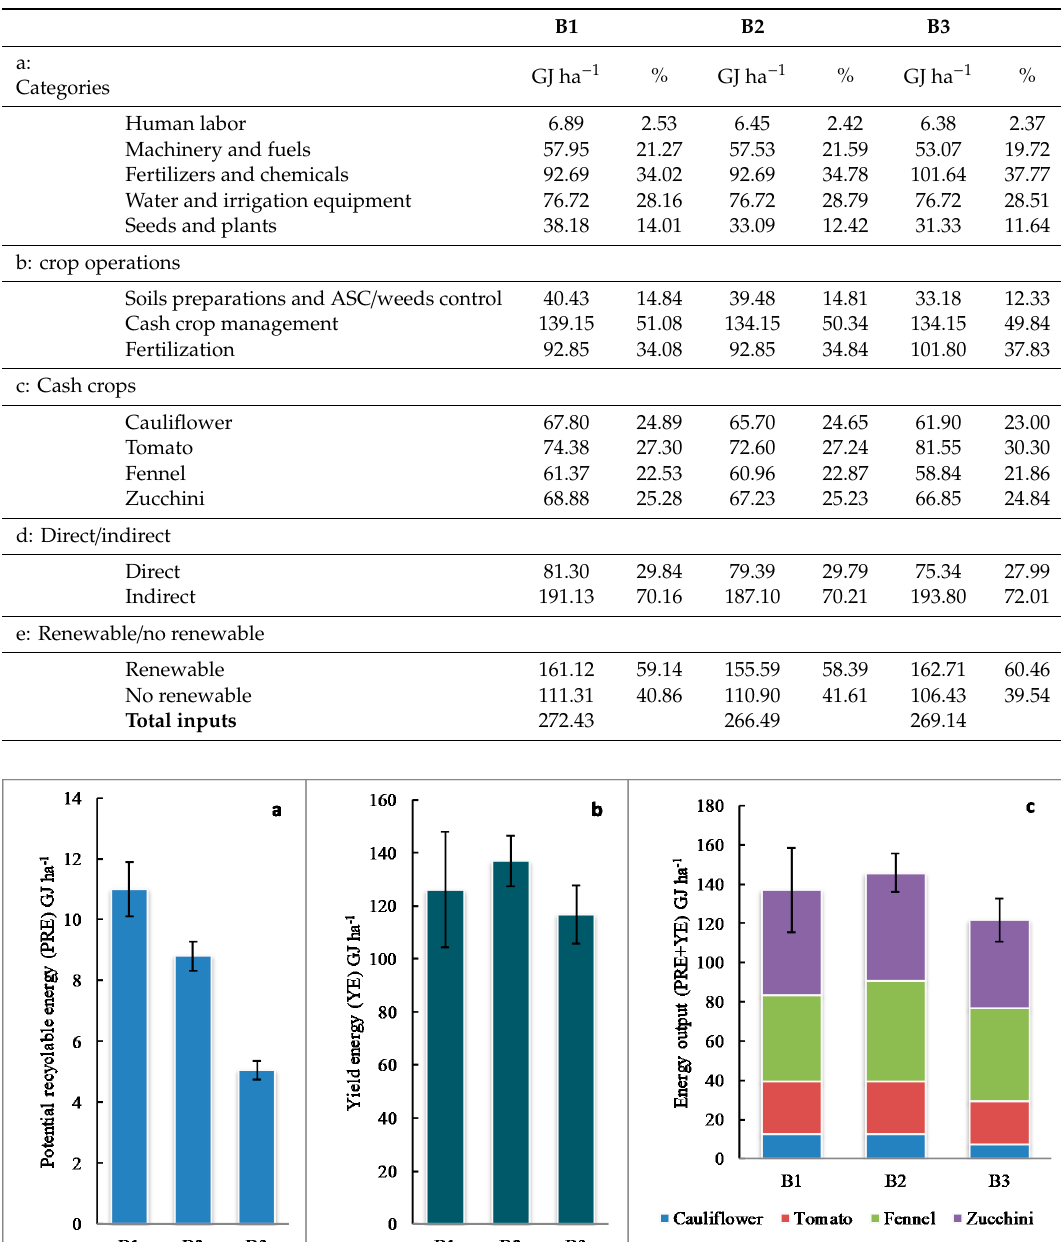
Table 4. Amounts of energy inputs, consumed in the four year rotations, expressed as total energy equivalents (GJ ha − 1 ) and percentage of total energy input (%) divided by categories ( a ), crop operations ( b ), cash crop ( c ), direct / indirect ( d ) and renewable / no renewable energy ( e ) (B1 = alfalfa as living mulch during both winter and summer periods, flattened with a no-till roller crimper; B2 = clover as living mulch during the winter period, chopped and plowed as green manure; B3 = control without ASC). The values are based on the whole four-year rotation.